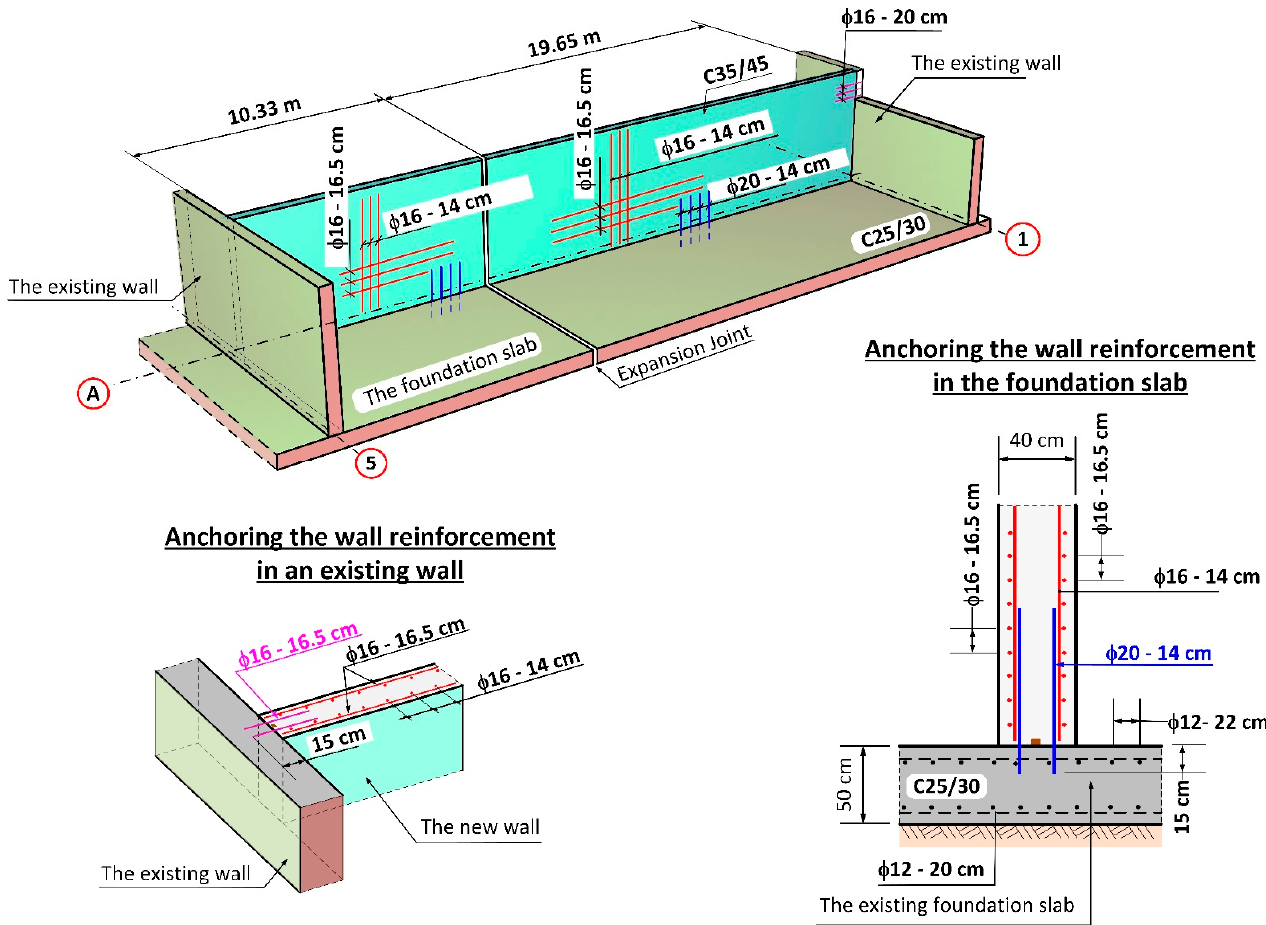
Figure 3. Scheme of the new wall structure on the A/1–5 axis according to the project design.